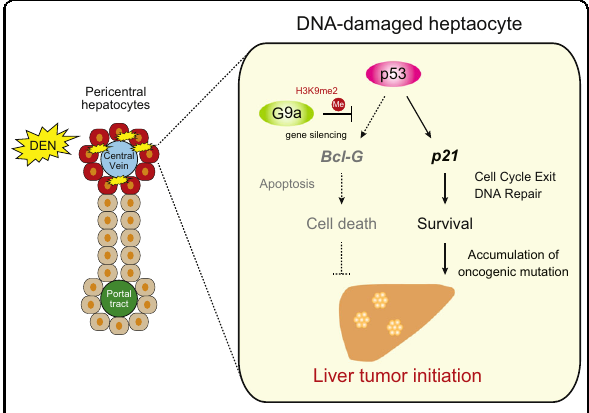
Fig. 6 Graphical scheme. Schematic representation of the G9a -p53- Bcl-G circuit that controls liver tumor initiation from DNA-damaged hepatocytes. DEN-exposed pericentral hepatocytes undergo DNA damage and mutagenesis. G9a allows DNA-damaged hepatocytes to escape p53-induced apoptosis, the potent genome surveillance checkpoint, via Bcl-G silencing, which results in the fi xation of mutations and promotion of future HCC development. In summary, G9a determines whether hepatocytes undergo apoptosis or survive during DNA damage response via the regulation of p53